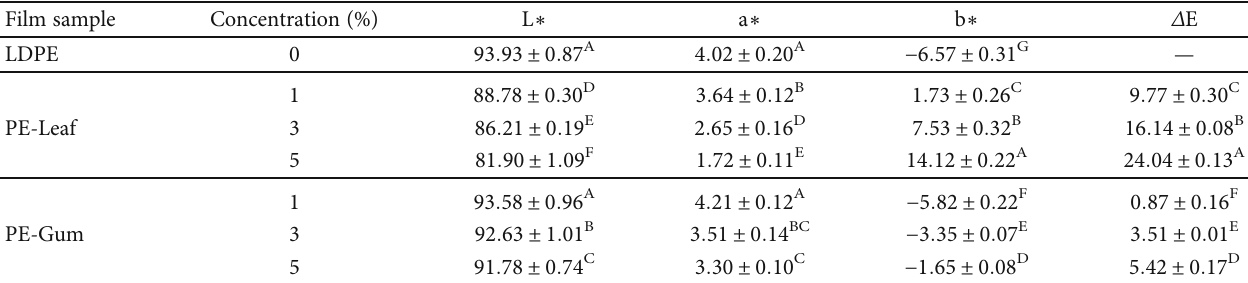
Figure 2: SEM surface images of fi lms with magni fi cation of 500 and 1500 (thumbnails): (a) LDPE fi lm; (b) PE-Gum-1; (c) PE-Leaf-1; (d) PE- Gum-5 (e); PE-Leaf-5. Table 3: Color parameters ( mean ± SD ) of control and active fi